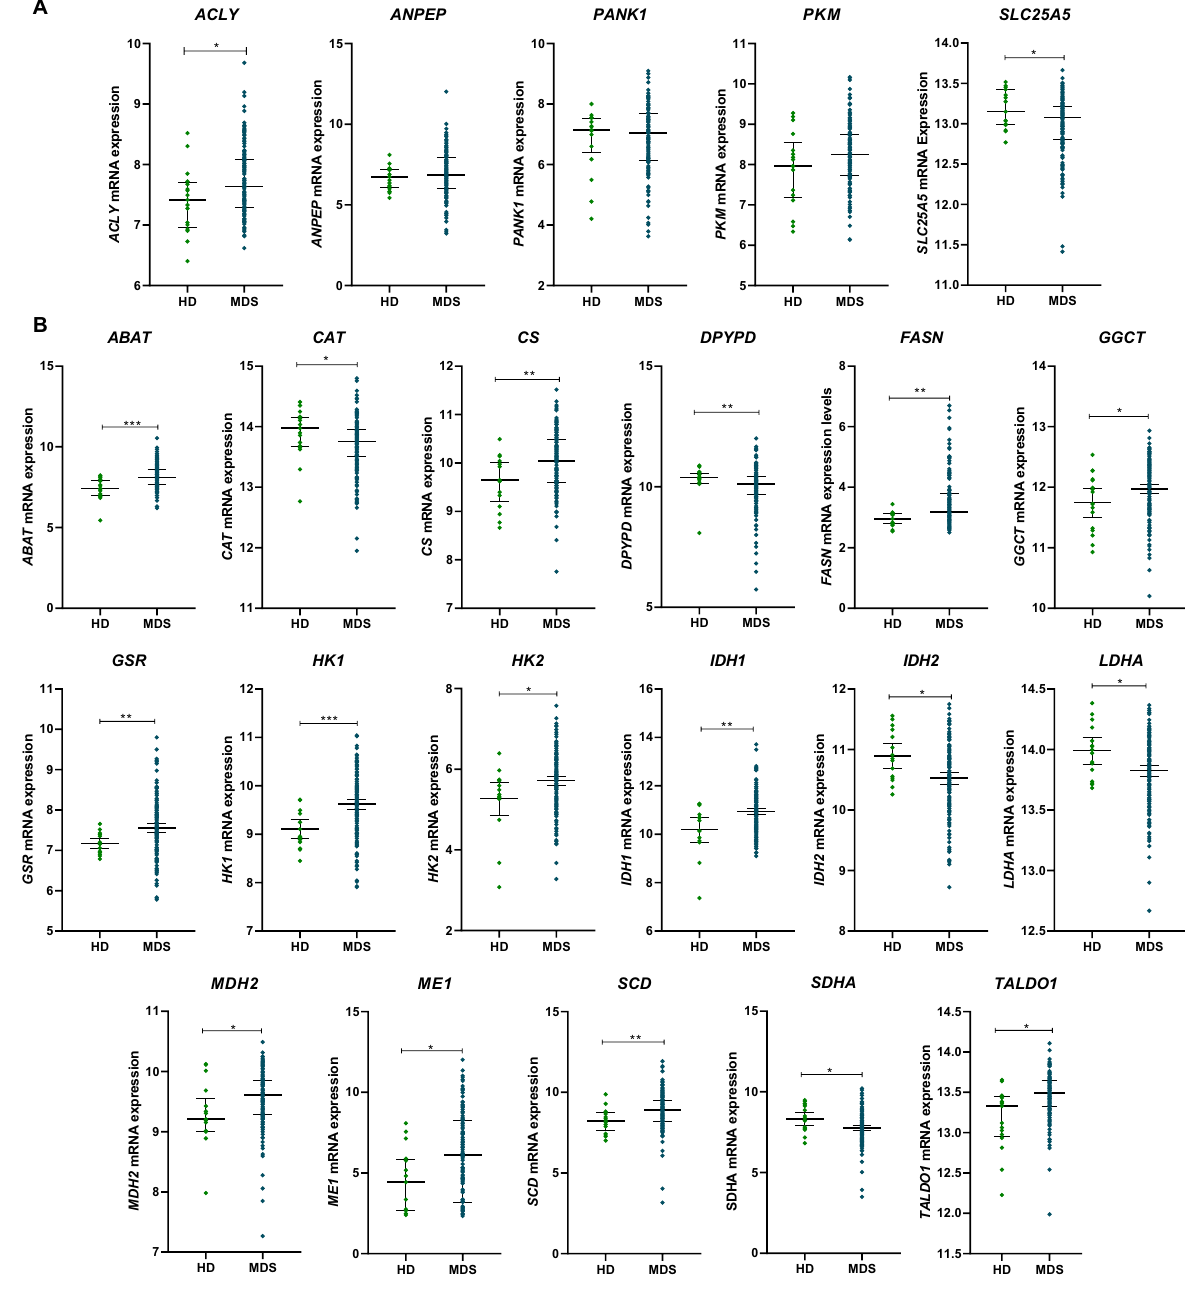
Figure 1. Gene expression from glycolysis and tricarboxylic acid cycle elements in CD34+ cells from healthy donors (HD) and myelodysplastic syndromes patients (MDS). A microarray-based gene expression analysis of selected genes for 17 HD and 159 MDS patients for selected genes used in Molecular Based Score (MBS) ( A ) and for genes differentially expressed between HD and MDS ( B ). Horizontal lines indicate medians and the P values are indicated. Notes: * P < 0.05, ** P < 0.01, *** P < 0.001; Mann–Whitney